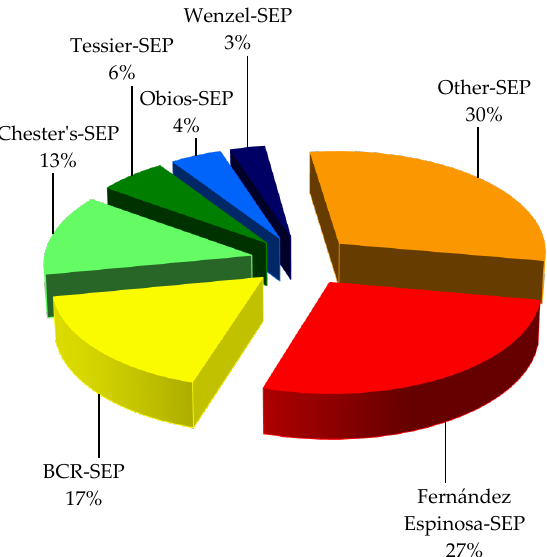
Figure 1. Sequential extraction procedures used for chemical fractionation of potentially toxic elements in airborne particles. Table 1. Most widely used original procedures for chemical fractionation of PTEs in atmospheric particulate